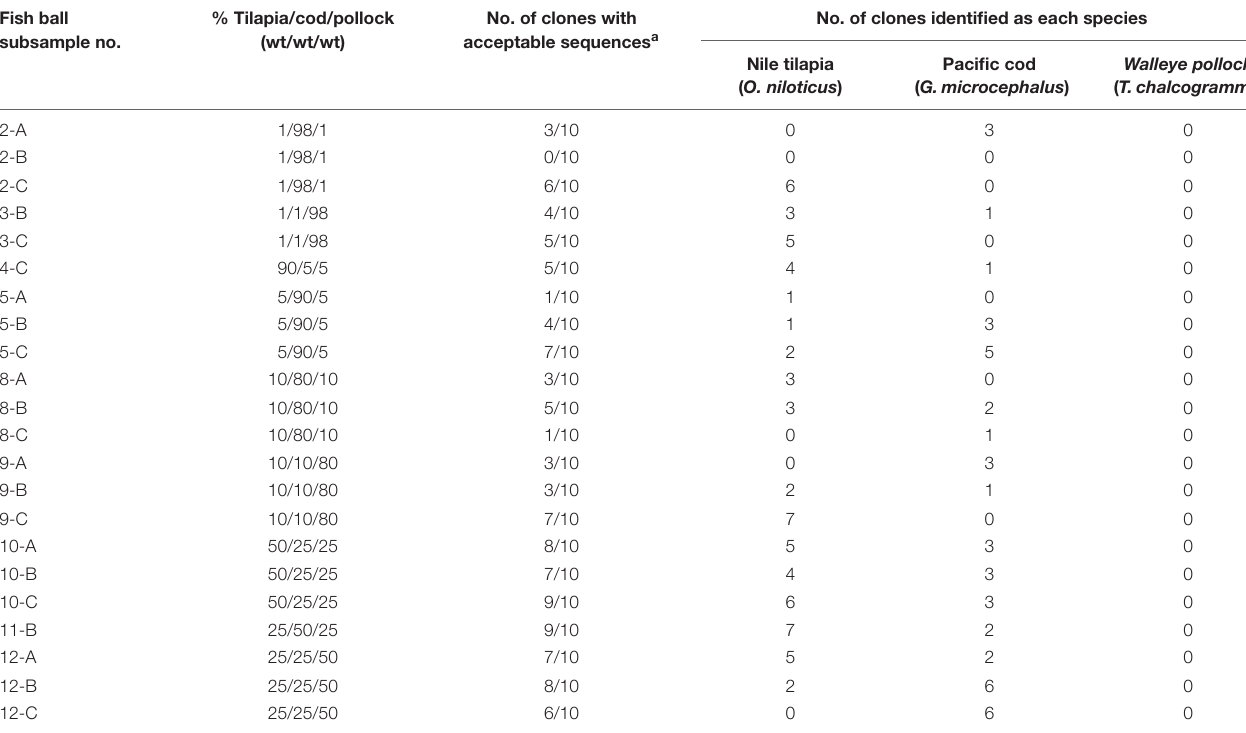
TABLE 5 | Sequencing results for fish ball subsamples that underwent PCR cloning and mini-barcoding after failing standard mini-barcoding. Fish ball subsample